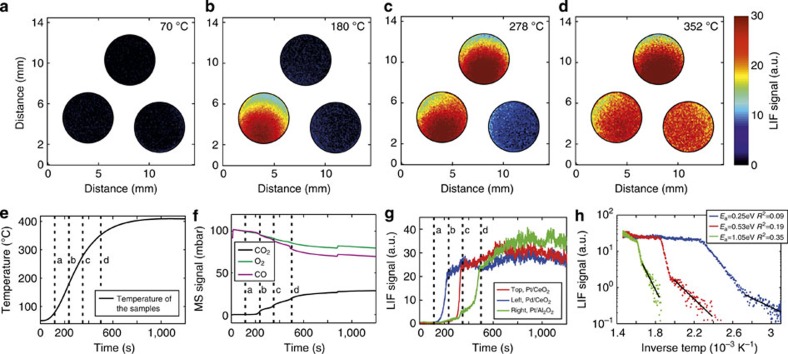
The CO2 signal from three different samples in three separate exhaust tubes.(a–d) The CO2 signal from the gas exiting the three tube ends are shown in the top panel (see Supplementary Movie 4). (e) The temperature measured by the thermocouple located centred between the tubes at the same position as the samples, (f) the MS signal during the event and (g) the averaged infrared PLIF signal exiting each tube, which is also shown in three Arrhenius plots in h.